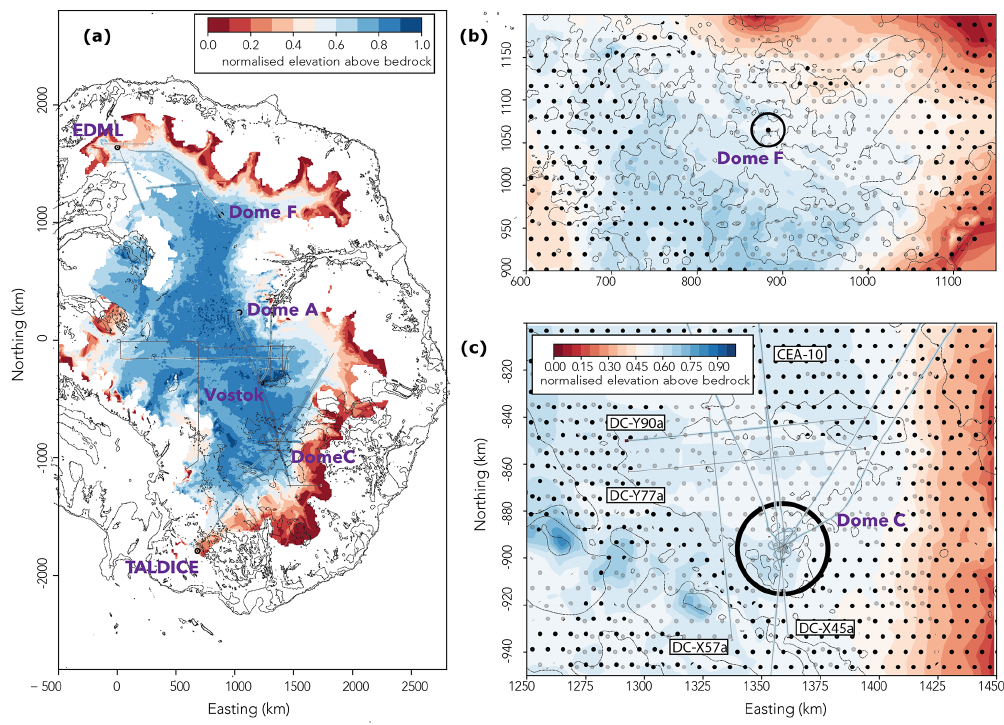
Figure 4. Computed isochrone elevation in East Antarctica. Panel (a) illustrates the elevation above bedrock of the 38ka isochrone normalised by the local ice thickness. The filled isochrone contours are overlain by the normalised elevation of the observed isochrones (thin coloured lines). Black shapes in (a) depict the zero-metre sea-level bedrock contour. Panel (b) shows a magnification of the region around Dome Fuji with dotted areas (filled black circles) where basal melt is simulated. Semi-transparent dots show results with geothermal heat flux forcing from Martos et al. (2017) and opaque dots from Shapiro and Ritzwoller (2004), respectively. Panel (c) shows the area around Dome C overlain by the normalised elevation of the observed isochrones (thin coloured lines). The mismatch between the simulated isochronal layer and the observed isochrone elevation along the transects is generally small in the Dome C region with the exception of the upper right section in (c) , where the simulated isochrone is off by up to 40% of the local ice thickness.